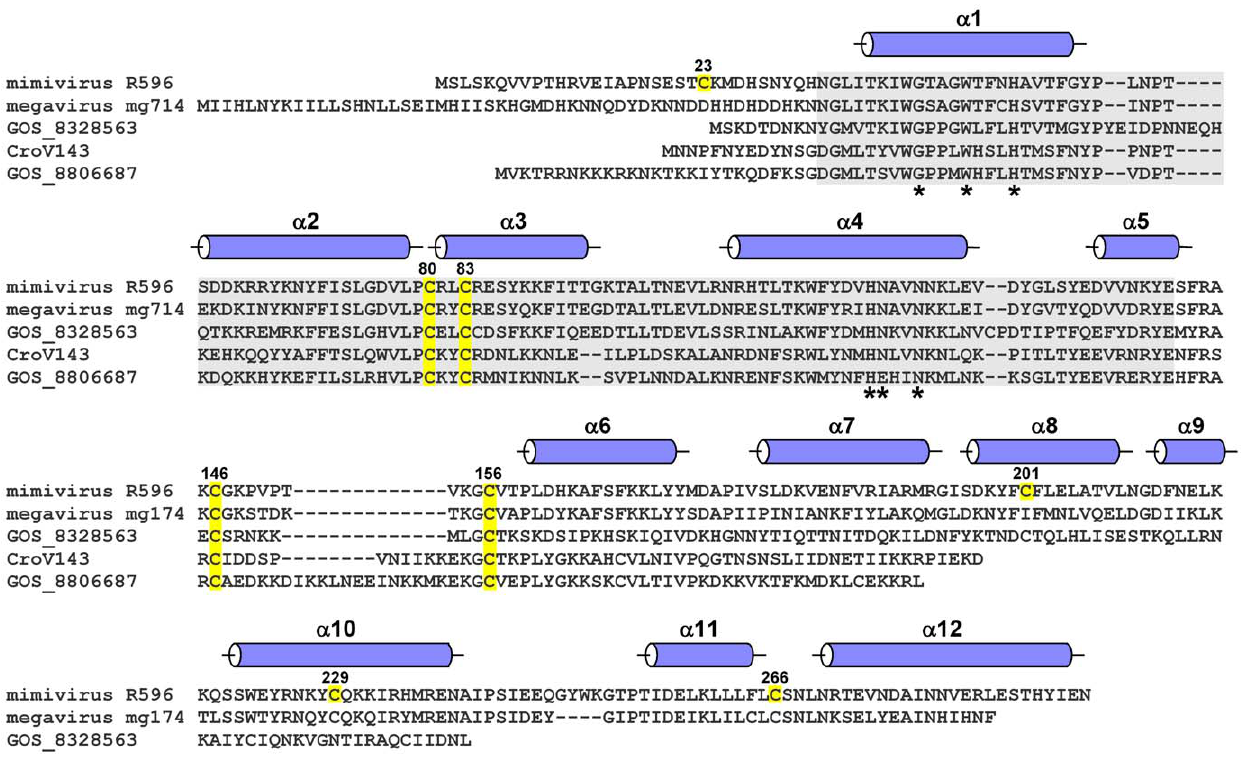
Figure 1. Amino acid sequence alignments of putative viral sulfhydryl oxidases related to mimivirus R596. Cysteine residues in R596 are highlighted in yellow and numbered according to amino acid position. The four cysteines shared in all aligned proteins are highlighted in all the sequences. The gray background indicates the region corresponding to the Erv family FAD-binding fold. Asterisks below columns in the alignment indicate conserved positions in the FAD-binding site. The positions of helices, according to the R596-4C structure, are shown as cylinders above the R596 sequence. Sequence accession numbers are: mimivirus R596: Acanthamoeba polyphaga mimivirus (YP_003987112); megavirus mg714: Megavirus chiliensis (YP_004894765); GOS_8328563: marine metagenome (EBM93594.1); CroV143: Cafeteria roenbergensis virus BV-PW1 (YP_003969775); GOS_8806687: marine metagenome (EBJ98940.1).